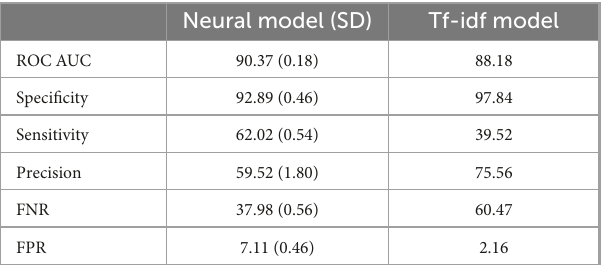
TABLE 3 Model performance.